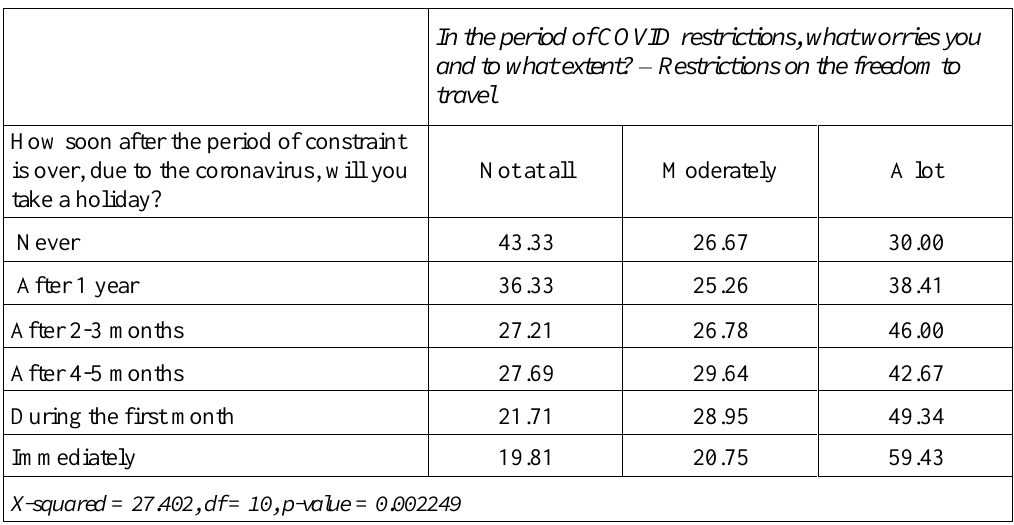
Table 4: Two-Way Table: Duration and how Soon after the Period of Constraint Is Over, Due to the Coronavirus, Will You Take a Holiday? (first wave) How soon after the period of constraint is over, due to the coronavirus, will you take a holiday?